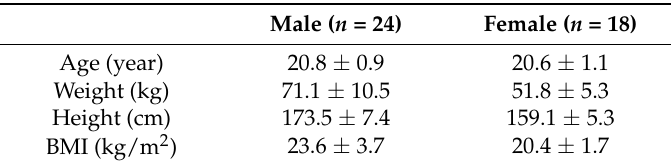
Table 1. Basic data of the study subjects.